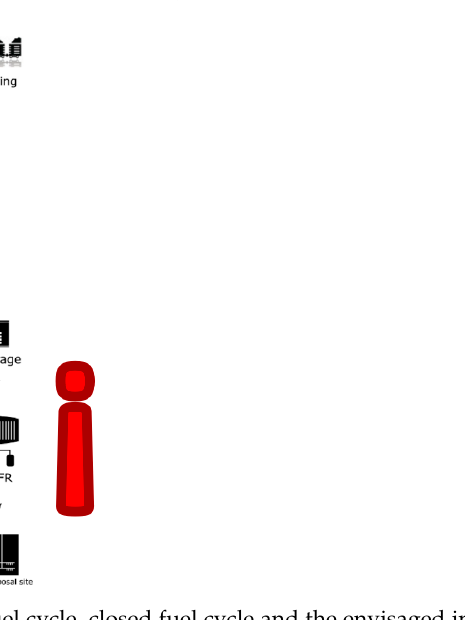
Figure 6. Fuel cycle options: open fuel cycle, closed fuel cycle and the envisaged implementation of iMAGINE.